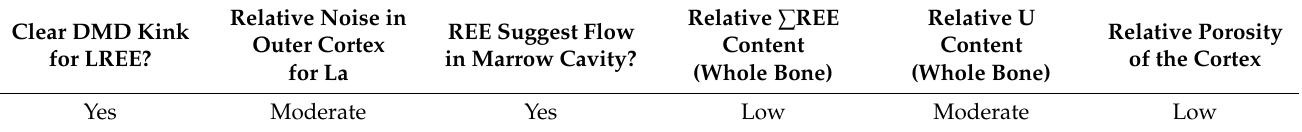
Table 2. Summary of the REE composition of the left tibia of Brachylophosaurus canadensis MOR 2598. Qualitative ∑ REE content is based on the value shown in Table 1 (256 ppm) in comparison to values from other Mesozoic bones (as listed in the main text). Abbreviations: DMD, double medium diffusion sensu [80]; LREEs, light rare earth